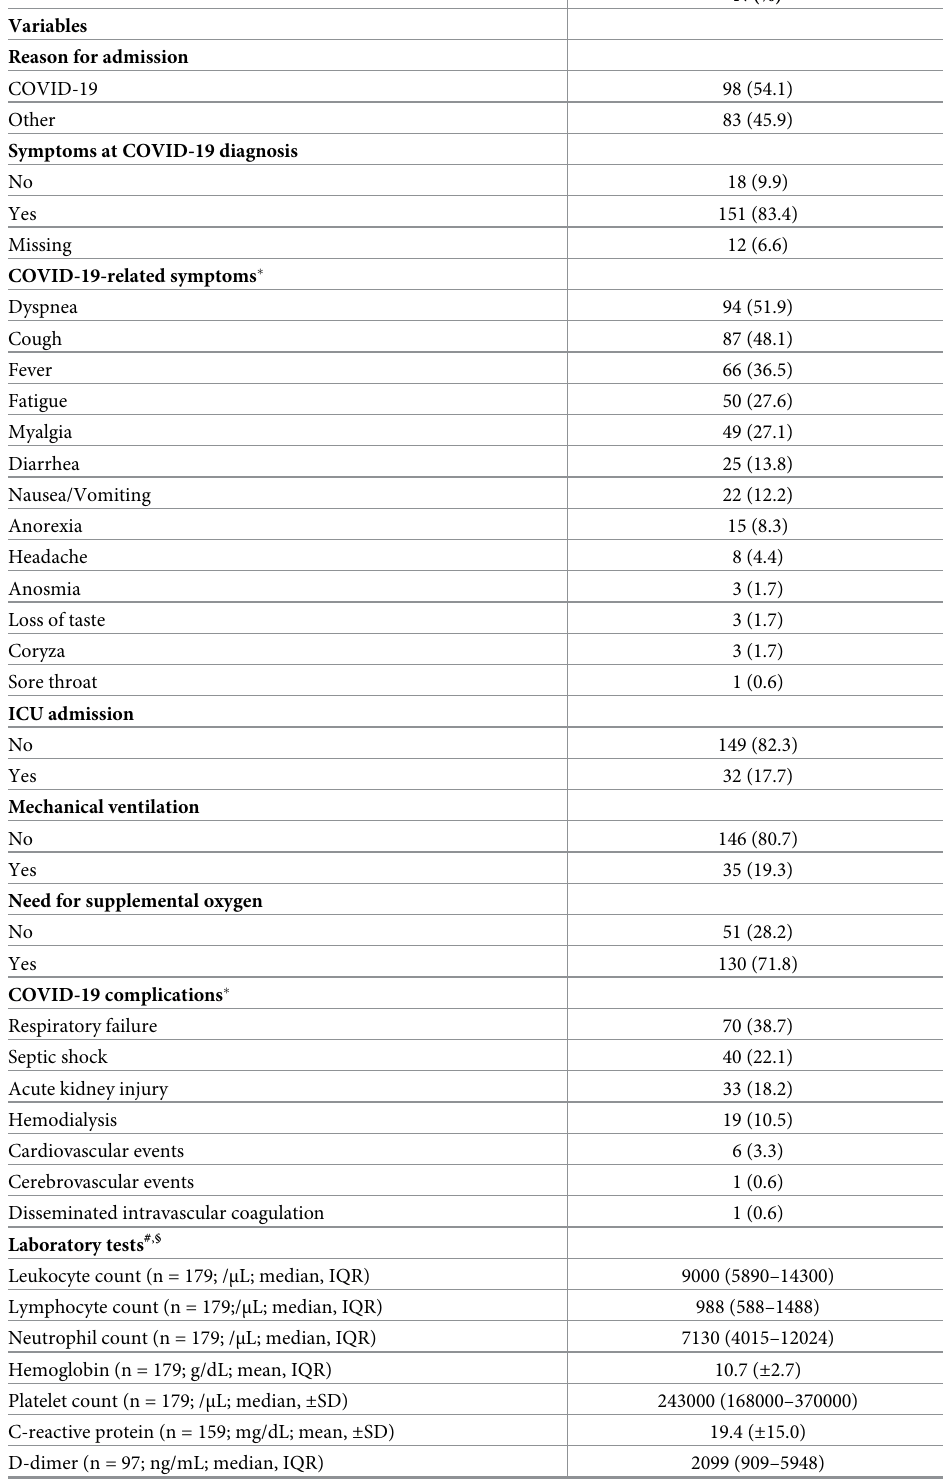
Table 2. Patient characteristics at admission and events throughout the hospital